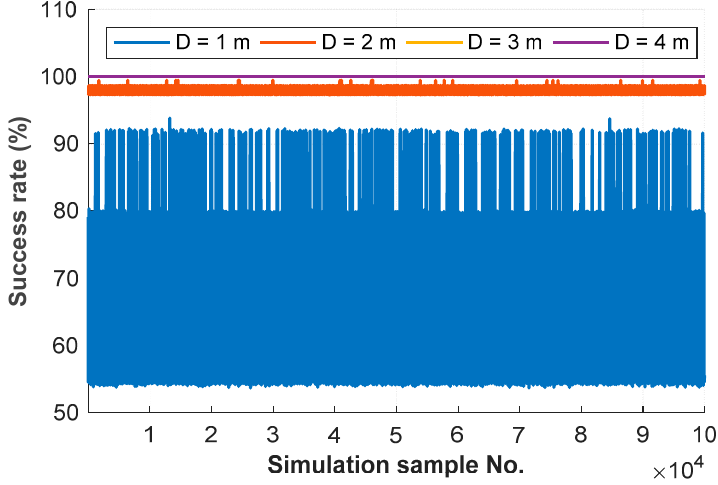
Figure 9. Illustration of computed lower-bound success rates of 10 5 samples of five geometry configurations, according to Equation (32) and Equation (34). Table 5. Statistical parameter of fail rates as function of the geometry change.